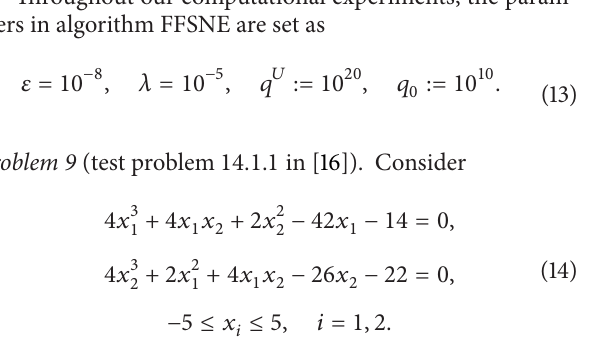
algorithm is referred as FFSNE (the filled function method for ( SNE )